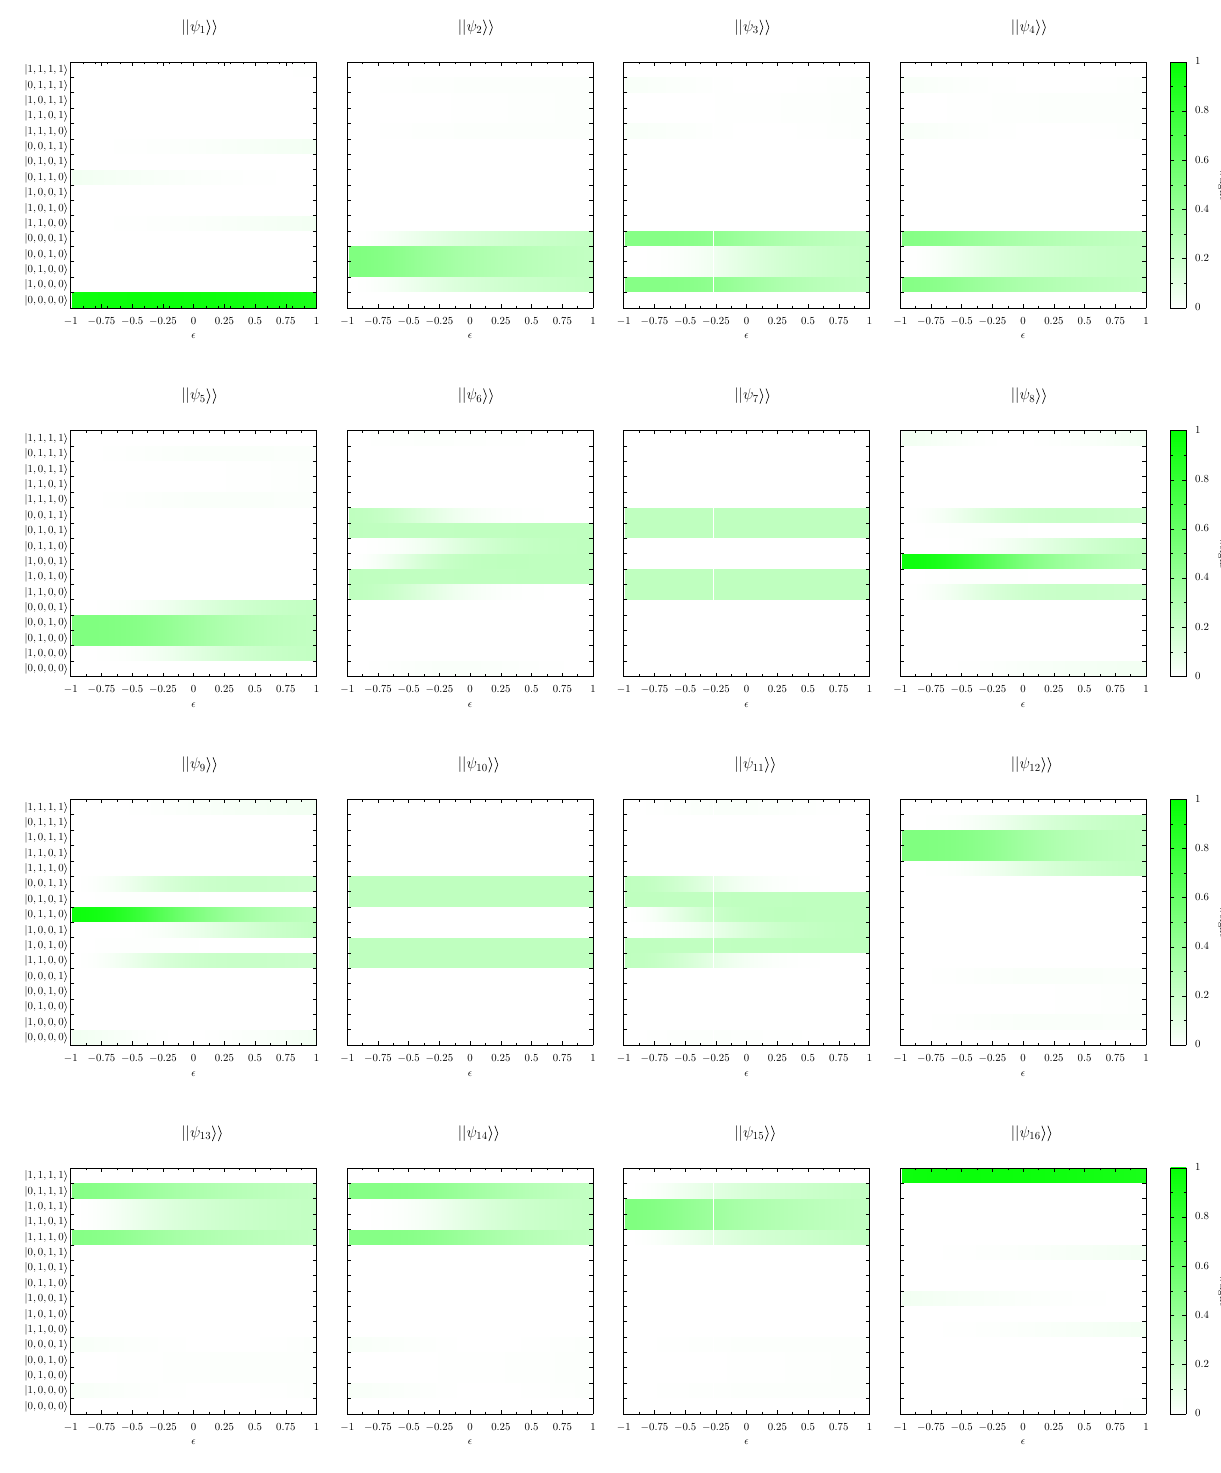
ψ n in the || �� i , j , k , l , as a function of the dimerization ǫ [cf. Eq. (7)]. | � 0.5 ω 0 , and the chain is of size N 16 4 (corresponding to a 2 4 = = =